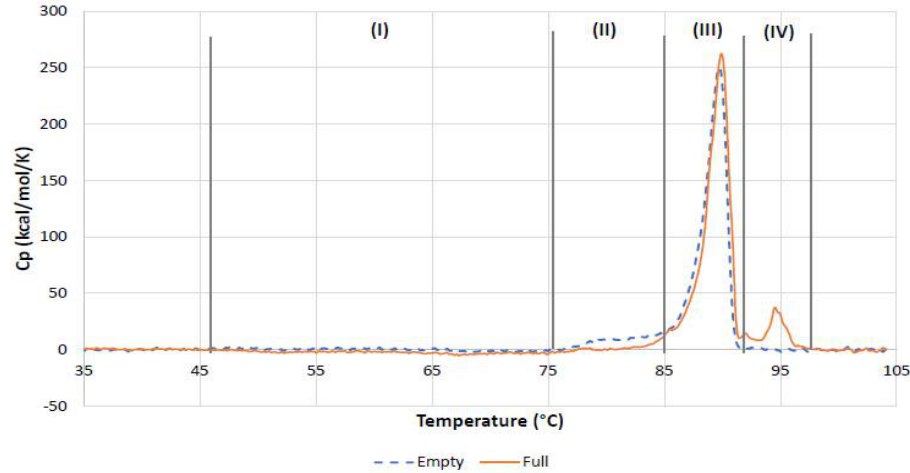
Figure 12. Overlay of the DSC traces of nominally empty and nominally full rAAV5 samples. DSC data corrected for the instrumental blank and the baseline. Vertical lines mark regions with distinctly different regimes of thermally induced processes.